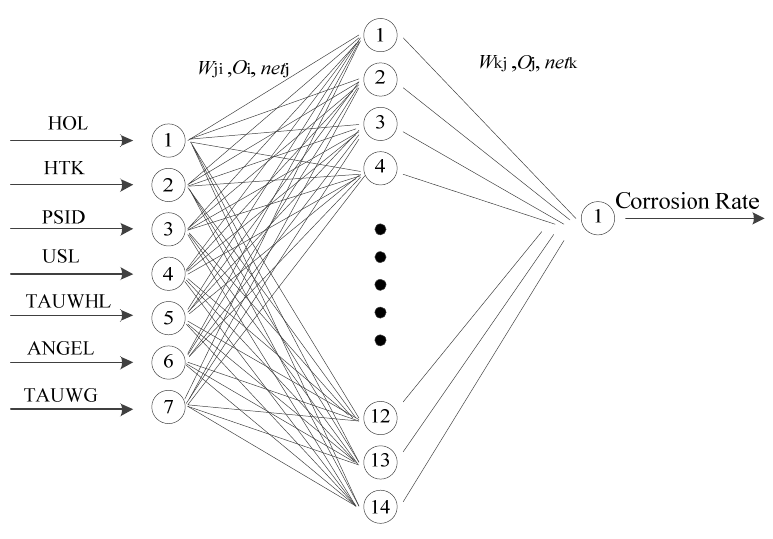
Figure 3. The neural network structure.